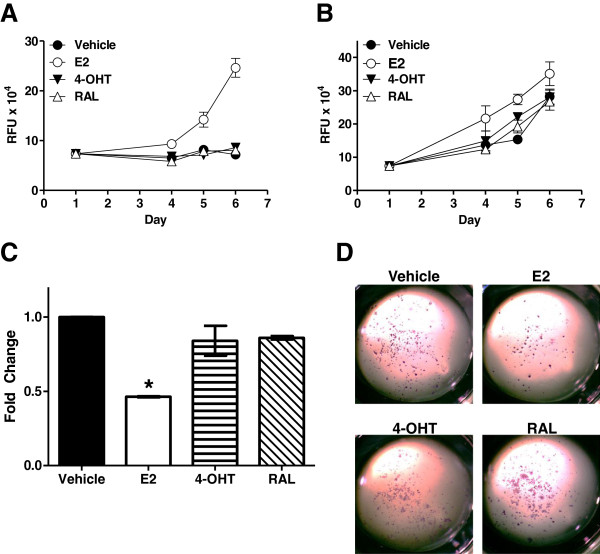
T47D:A18/PKCα cells are resistant to 4-OHT and RAL in 2D and 3D cell culture. DNA and Matrigel™ colony formation assays were performed as described in materials and methods. Cells were grown in the presence of vehicle (DMSO, 0.1%), E2 (10-9M), 4-OHT (10-7M) or RAL (10-7M) with media changes every three days. A. T47D:A18/neo cells. B. T47D:A18/PKCα cells. RFU, relative fluorescence units. C. Quantification of T47D:A18/PKCα colonies. Graphs are representative of at least three independent experiments and error bars represent SEM. *P < 0.05 compared to vehicle; by one-way ANOVA followed by Bonferroni’s post-test. D. Photographic representation of T47D:A18/PKCα colonies. Total magnification: 6X.